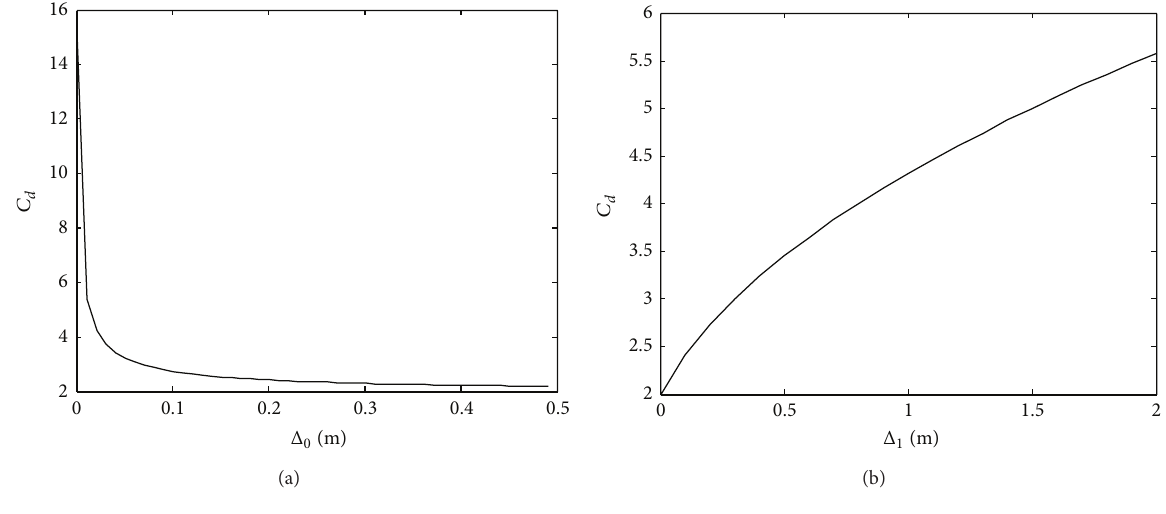
Figure 11: The relation between 𝐶 𝑑 and Δ 1 , Δ 0 .